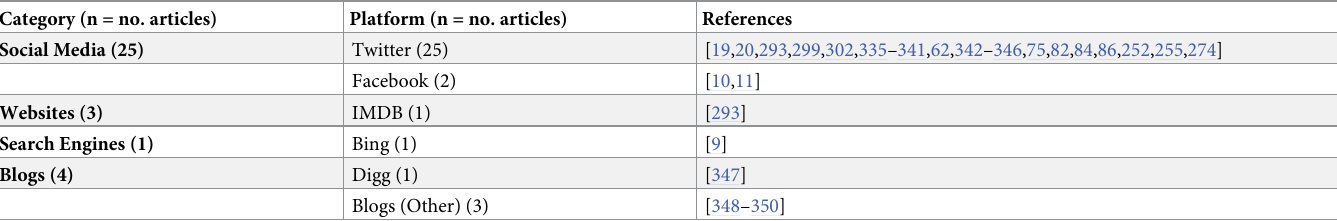
Table 7. Number of articles predicting political orientation, with associated platforms and references. Category (n = no. articles) Platform (n = no.